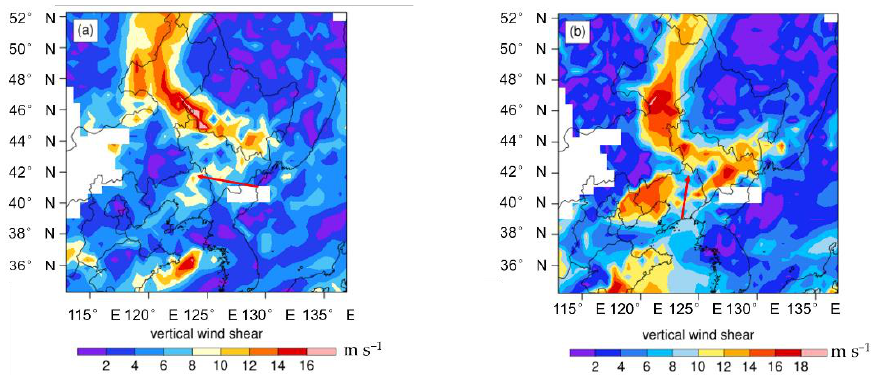
Figure 9. Vertical wind shear between 1000 and 3000 m (m · s − 1 ) at ( a ) 08:00 LST; ( b ) 17:00 LST in Domain 2 on 3 July 2019.